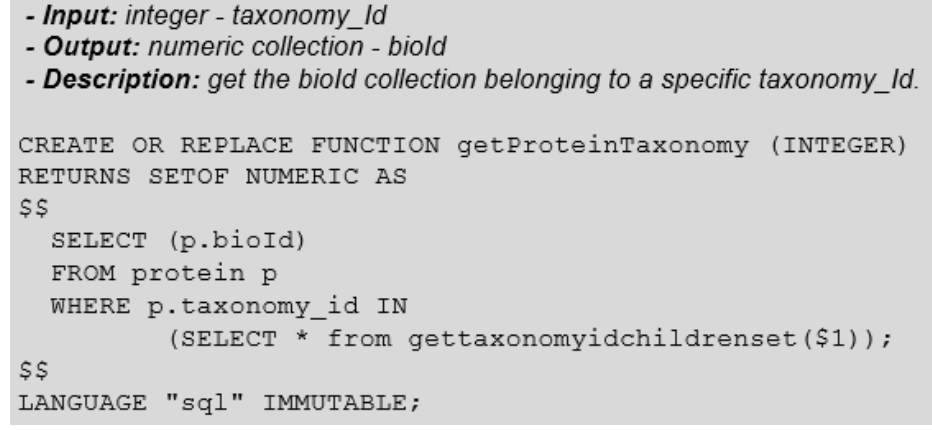
Figure 14. Function: